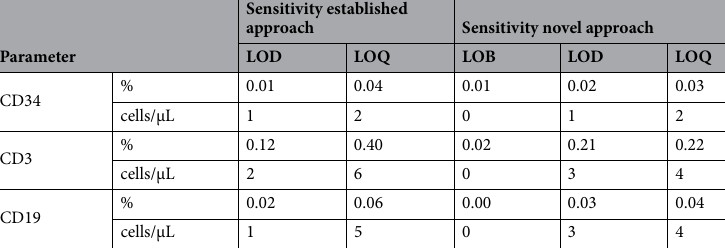
Sensitivity established